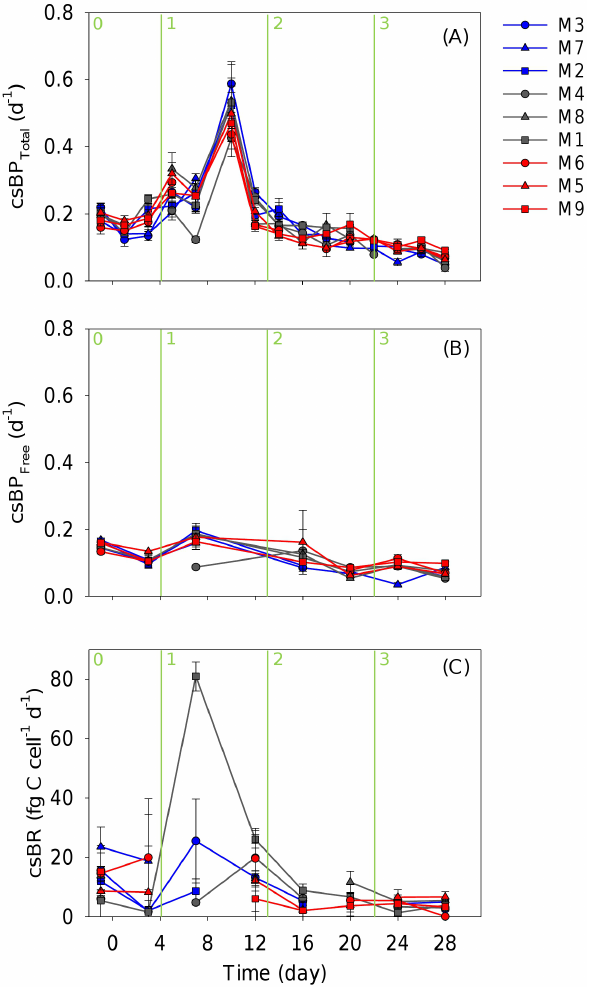
Fig. 2. Temporal variation of bacterial growth rate of the unfiltered fraction (A) and bacterial growth rate of filtered fraction (B) , and cell specific bacterial respiration (C) . Values are means ± stand de- viations for triplicate measurements ( n = 3). For colour and symbol coding, see Fig. 1.